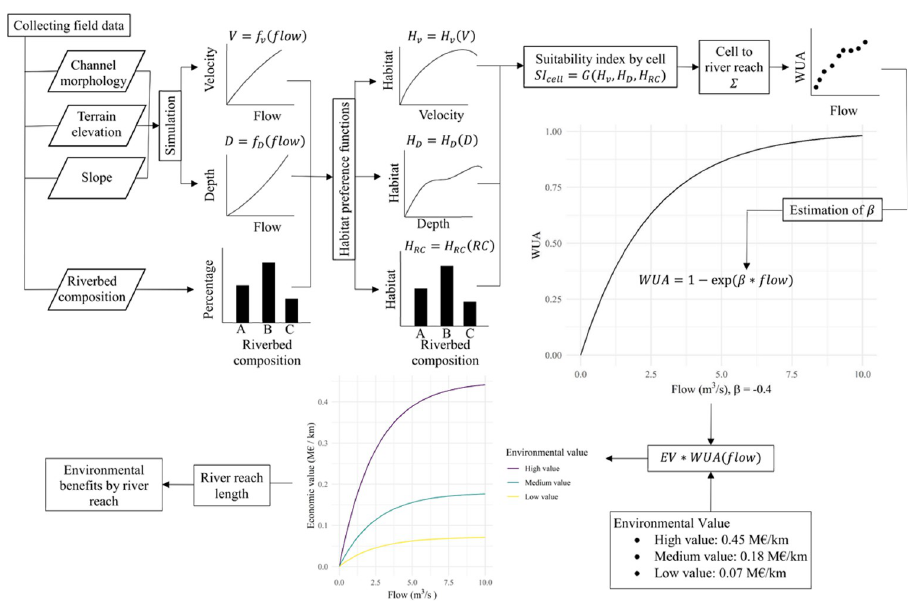
Fig 1. Environmental benefit response using the weighted usable